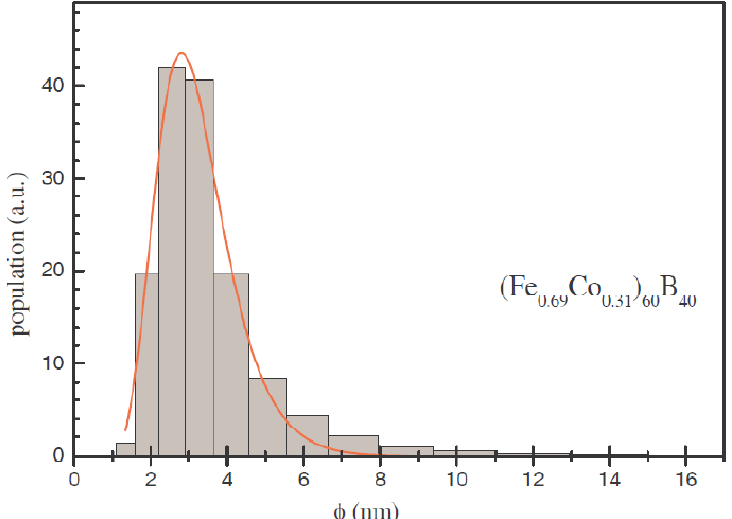
Figure 1. Size distribution of the (Fe scattering method (bars). The solid line corresponds to the least-square fitting of the data with a log-normal